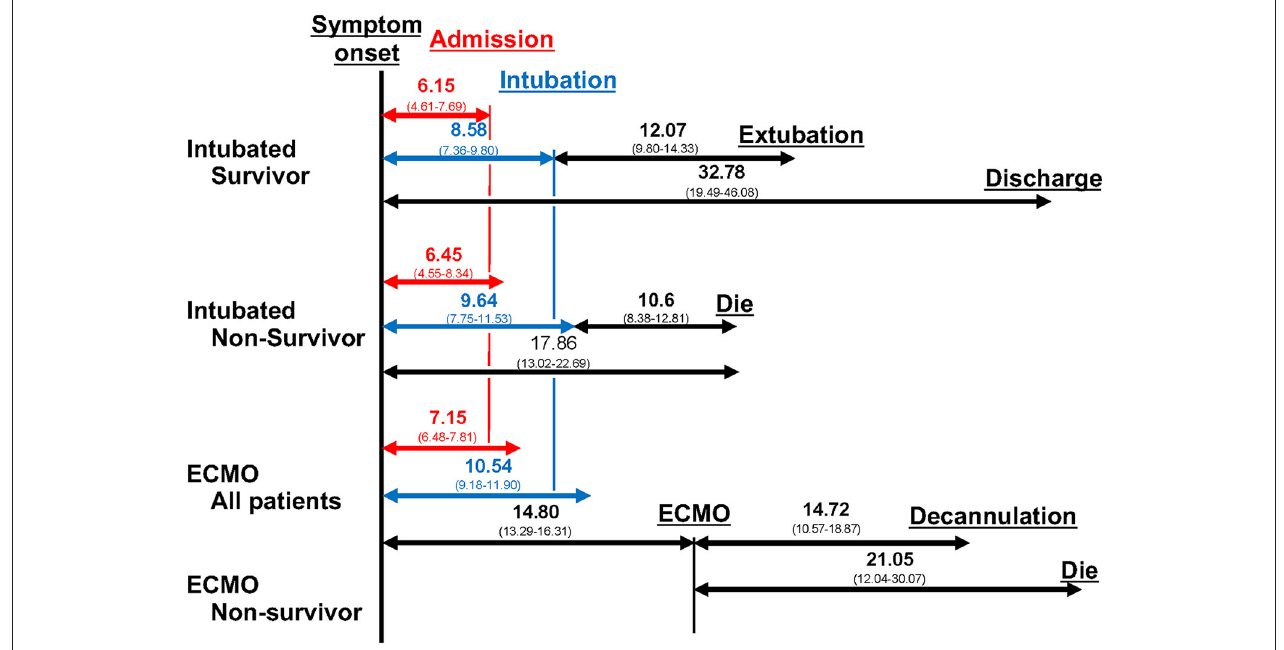
FIGURE 5 | Clinical course. The duration from symptoms to each clinical event, from intubation to each clinical event, and from ECMO to each clinical event are shown. The number is the mean number of days, and the number in parentheses is the 95% confidence interval.